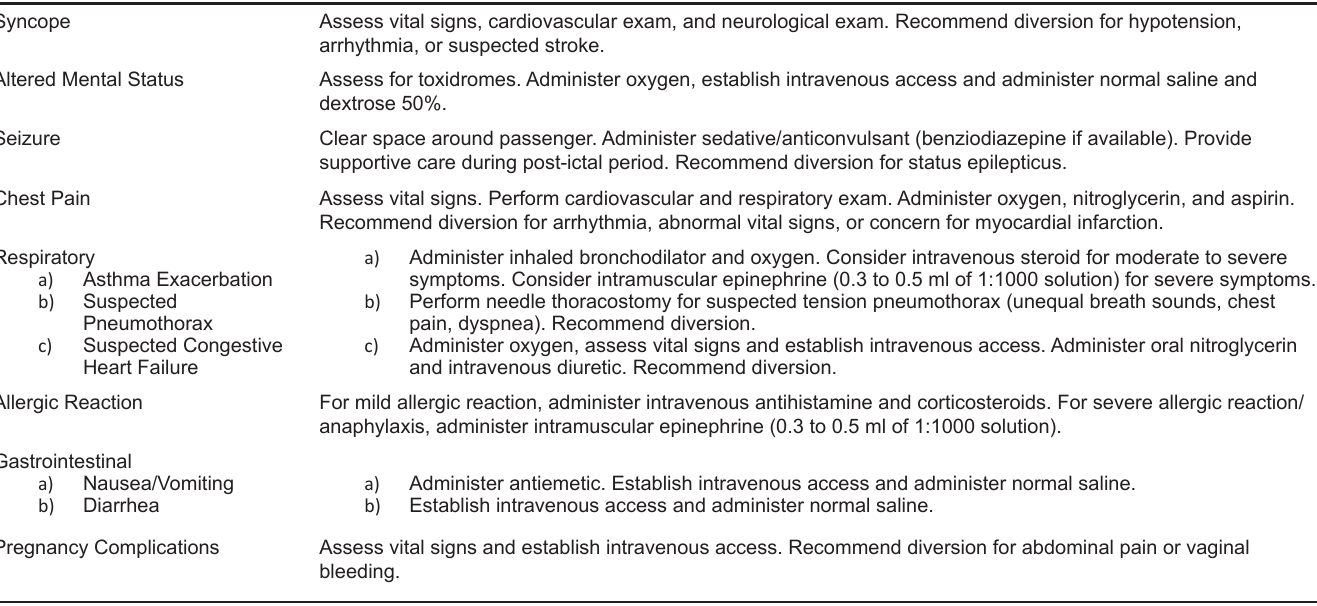
Table 5. Approach to common in-flight medical